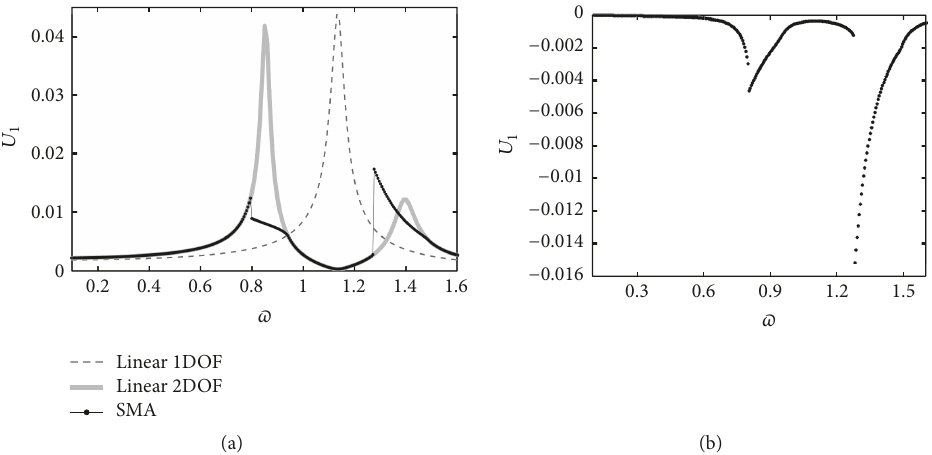
Figure 6: Primary system response in up-sweep test: (a) maximum amplitude; (b) bifurcation diagram.